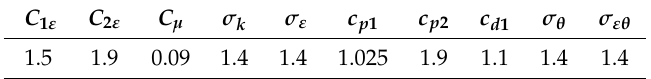
Table 1. Values for the KLW model constants in Equations (8)–(11)